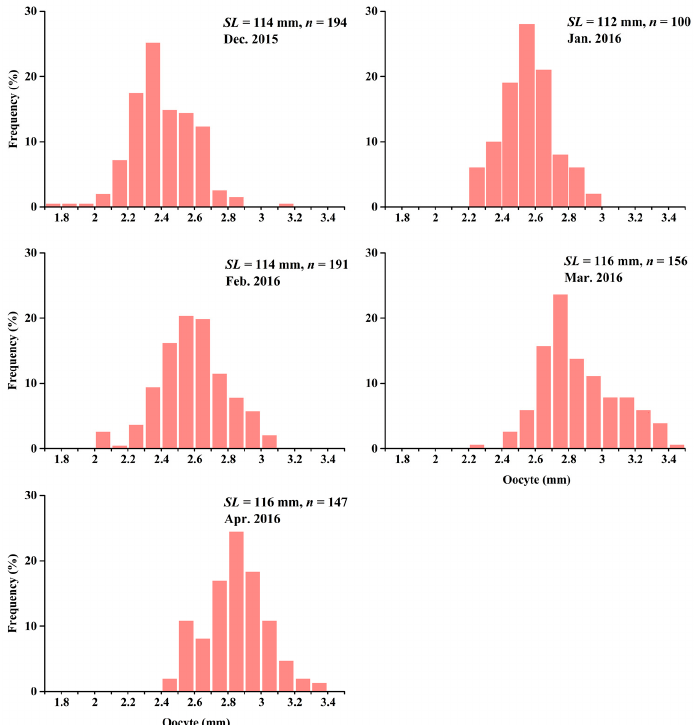
Figure 7. Monthly frequency distribution of oocyte diameter of G. tibetana in the lower Yarlung Tsangpo River from December 2015 to April 2016.